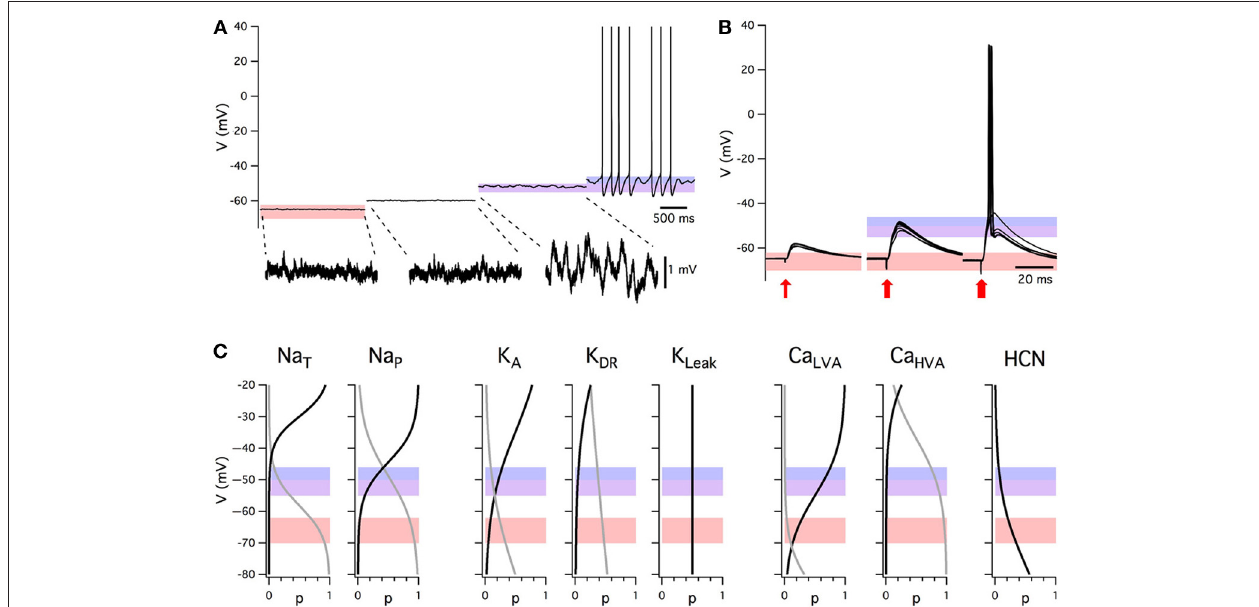
FIGURE 1 | Summary of intrinsic electrophysiological properties of stellate cells from layer II of the medial entorhinal cortex. (A) Example of membrane potential activity at rest and during injection of constant current. Shading indicates the range of typical resting membrane potentials (orange), peri-threshold theta-frequency activity (purple), and threshold for initiation of action potential firing (blue). Subthreshold activity is shown on an expanded voltage-scale below. (B) Examples of excitatory post-synaptic potentials evoked by stimuli of increasing amplitude (left to right). Each block shows five consecutive responses to stimuli of identical intensity. Data in A and B are obtained with whole-cell patch-clamp recordings from the same stellate cell in the presence of picrotoxin (50 µ M) and CGP55845 (1 µ M) to block inhibitory synaptic transmission. (C) Voltage dependence of stellate cell conductances. Boltzmann fits for activation (black) and inactivation (gray). From left: Na T : activation ( V 1 / 2 = − 29 . 9mV, k = 3 . 9mV) and inactivation ( V 1 / 2 = − 58 . 2mV, k = − 5mV) [Magistretti